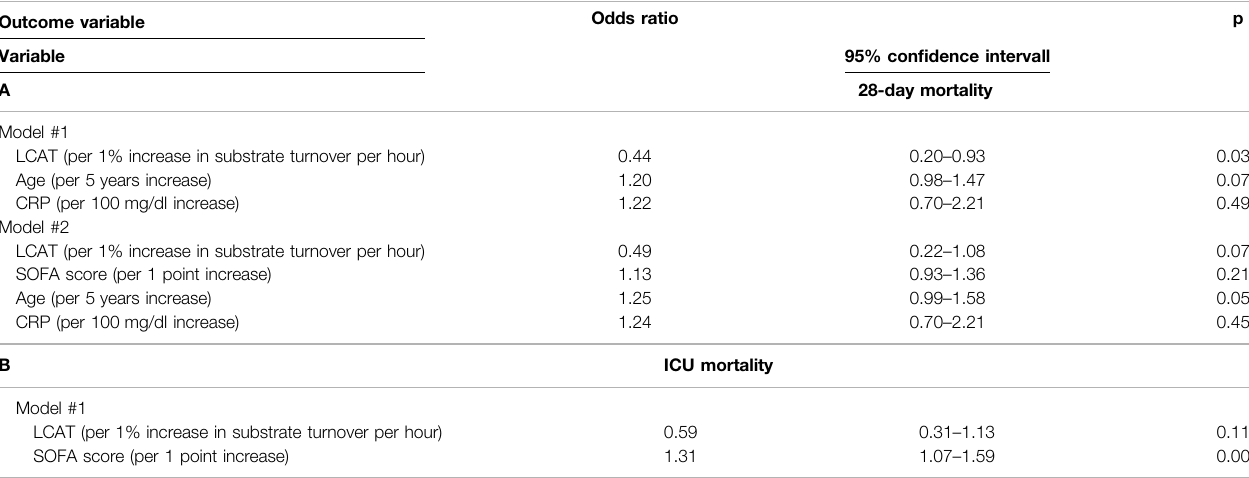
TABLE 4 | Multivariable logistic regression for 28-day (A) and ICU- (B) mortality in the sepsis